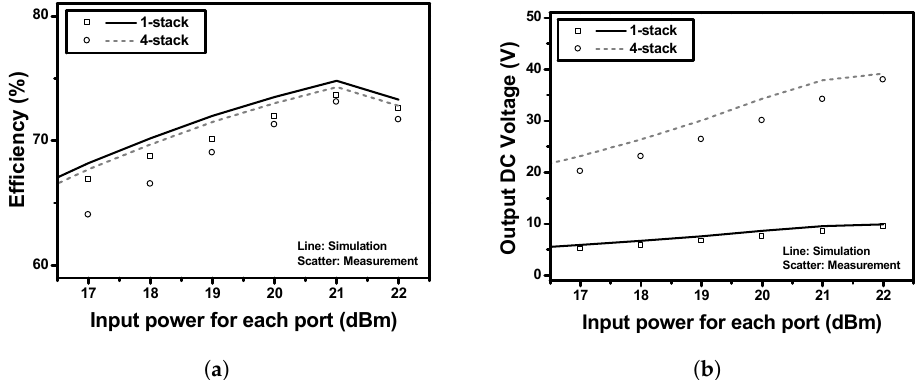
Figure 13. Simulated and measured results of the implemented single-stack and 4-stack RF–DC converters, ( a ) efficiencies and ( b ) output DC voltages.